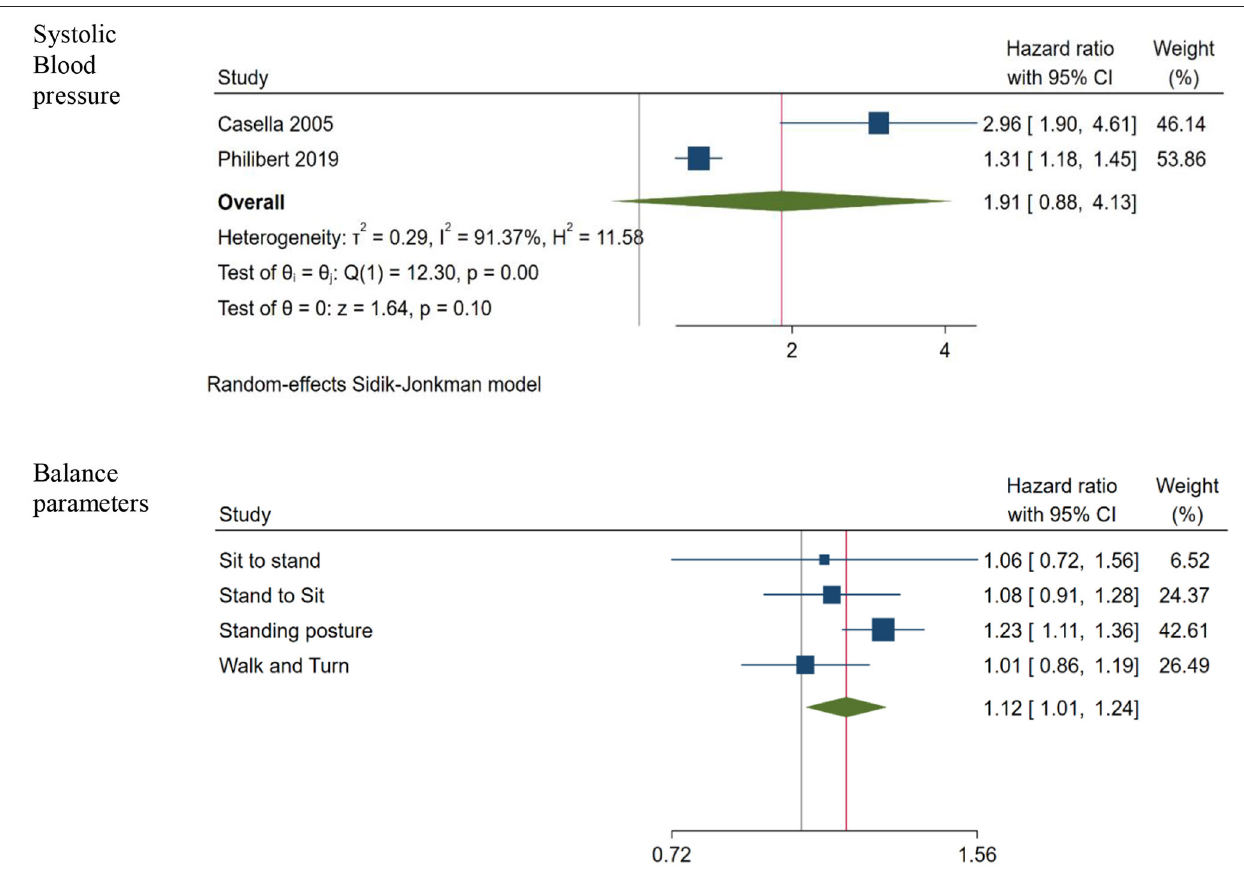
FIGURE 2 | Forest plots for predictors of